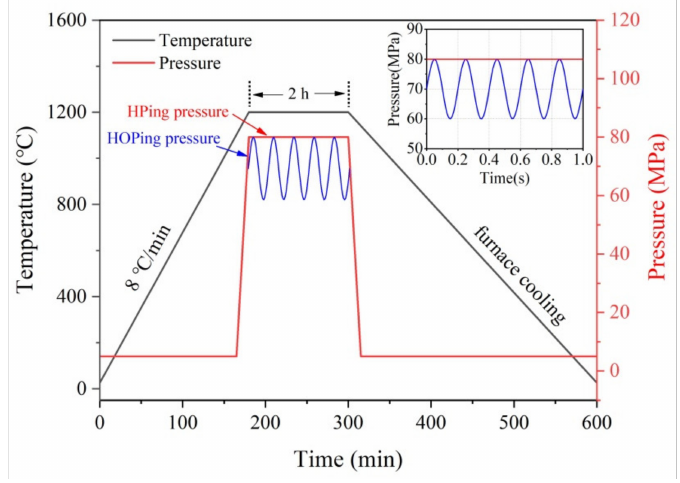
Figure 1. The sintering process of the HOPing and HPing samples at 1200 ◦